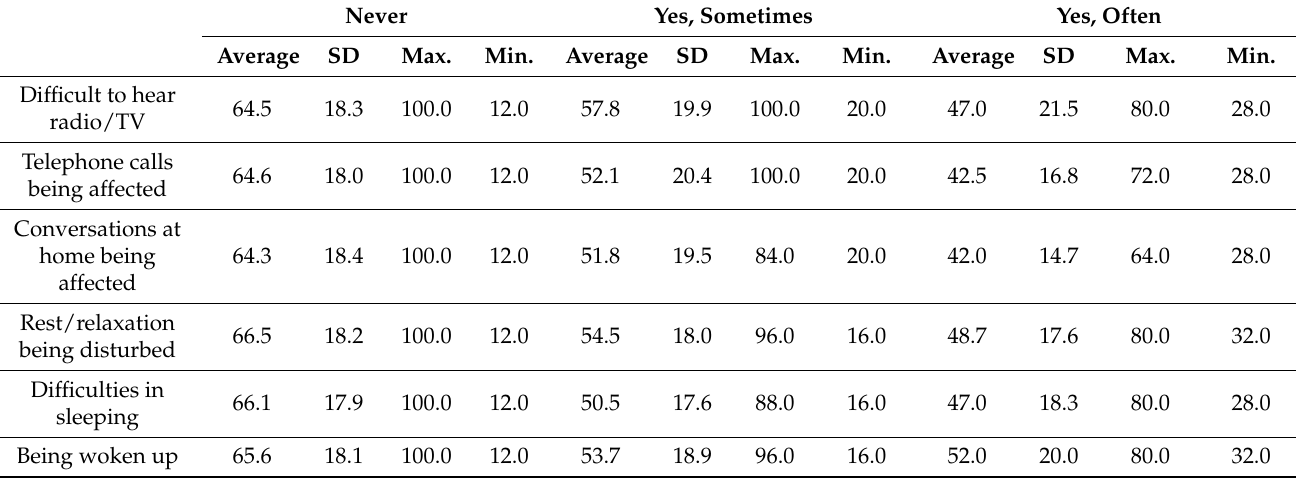
Table 3. Relationship between well-being level and the disturbing effect of traffic noise in the life at home. The table shows participant’s average score, standard deviation, maximum and min- imum punctuation in the Five Well-Being Index (WHO-5). For the interpretation, it should be taken into account that a score of 0 represents worst thinkable well-being, and 100 is the best thinkable